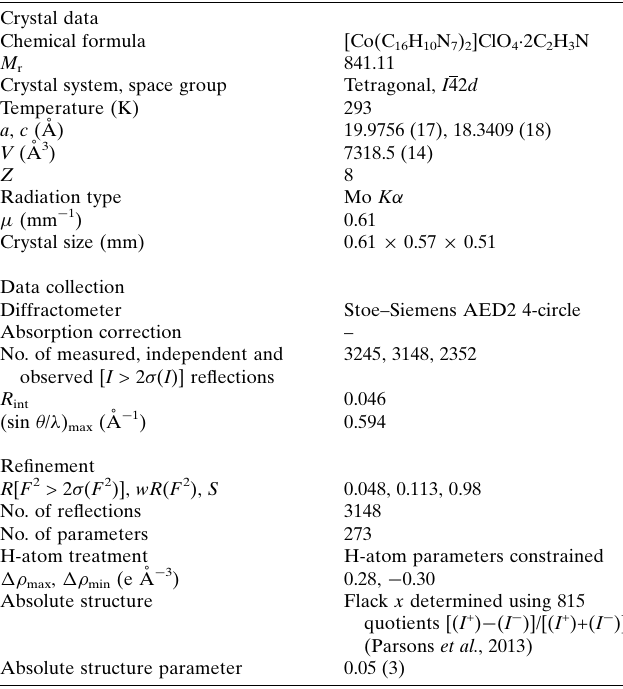
Table 2 Experimental details. Crystal data Chemical